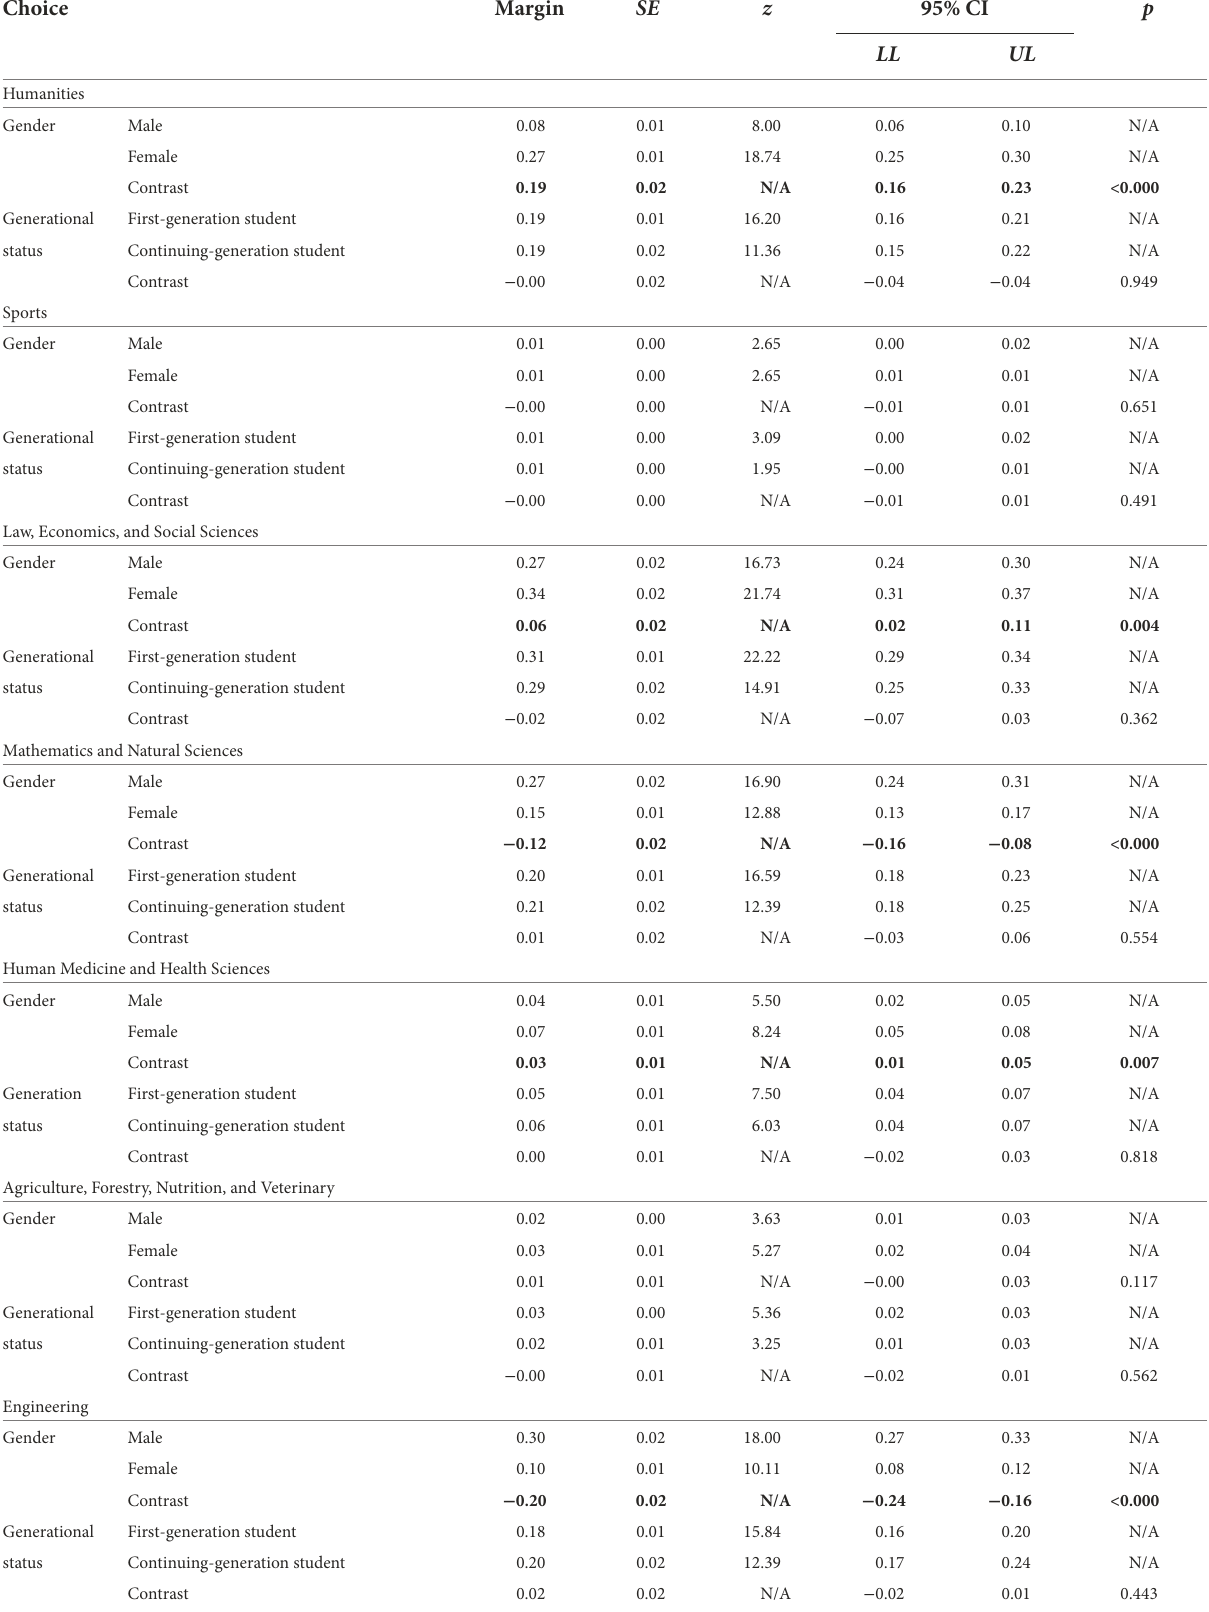
TABLE 4 Marginal means for study program choice predicted by gender and generational status (SES controlled). Choice